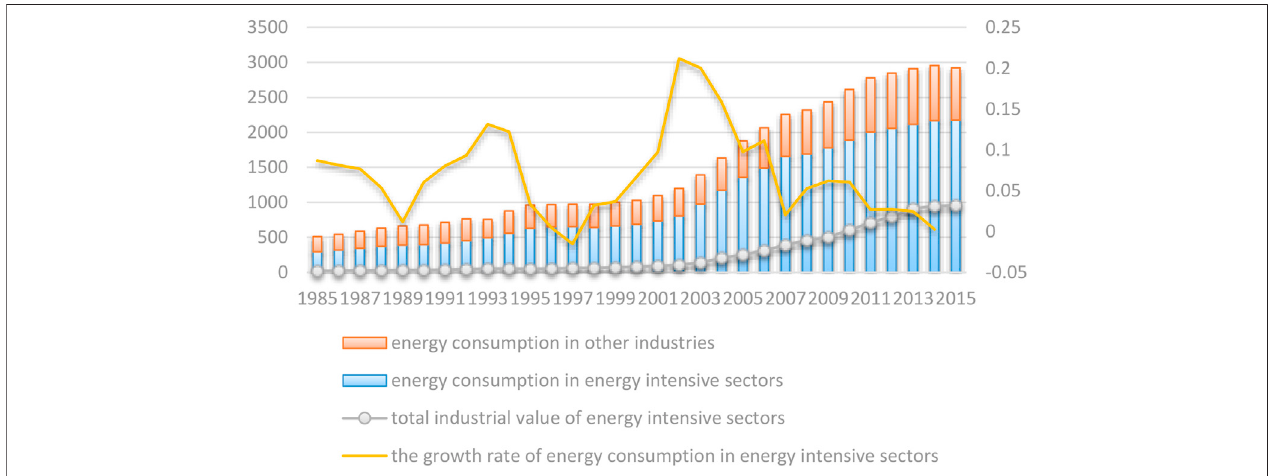
FIGURE 1 | Energy consumption and industrial output in China ’ s EIIs.